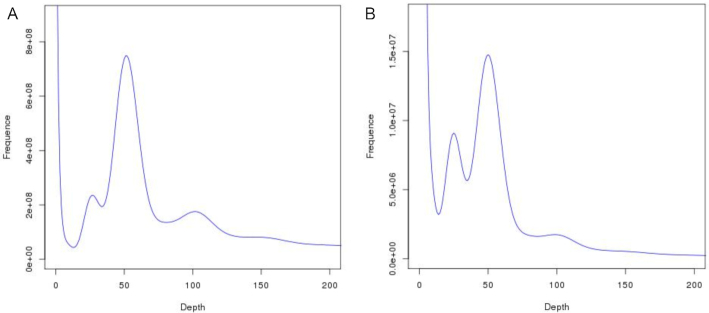

k-mer distribution of the T. aralioides genome. (A) k-mer depth and number frequency distribution; (B) k-mer depth and k-mer species number frequency distribution.